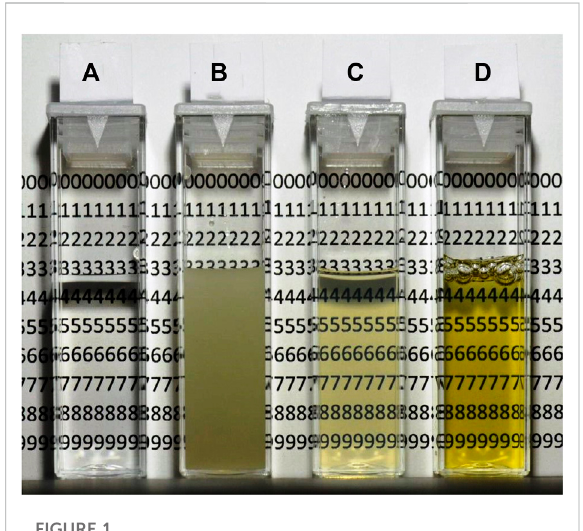
FIGURE 1 Transparency of E. coli suspensions in solutions with